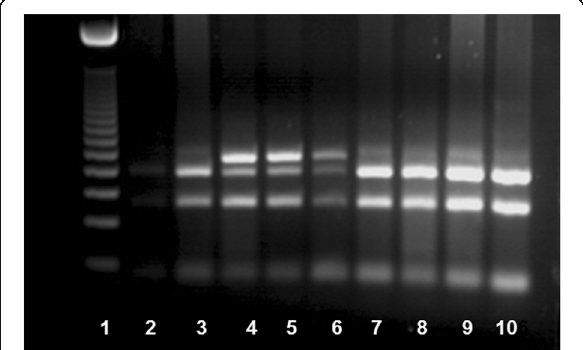
Fig. 1 INS -23 Hph1 A>T polymorphism. Lane 1: 50 bp ladder, lanes 3 and 7 – 10: Wild type ( AA ) 191 and 129 bp; lanes 4-6: heterozygous ( AT ) 231, 191, and 129